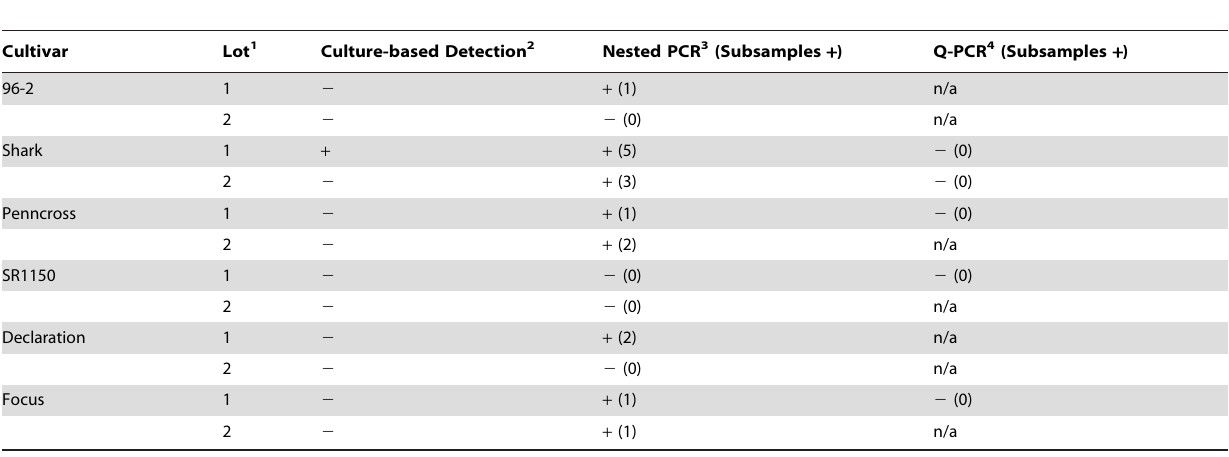
Table 4. Results for S. homoeocarpa contamination of creeping bentgrass commercial seed lots by culture-based and molecular detection methods.